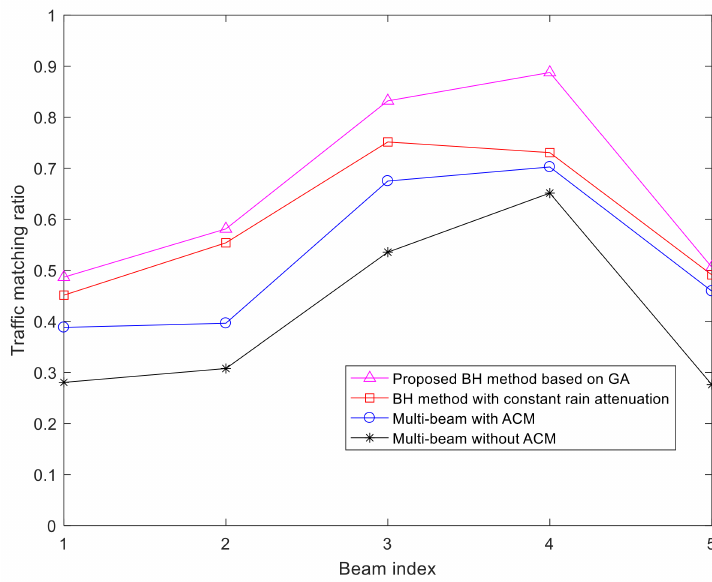
Figure 8. Traffic matching